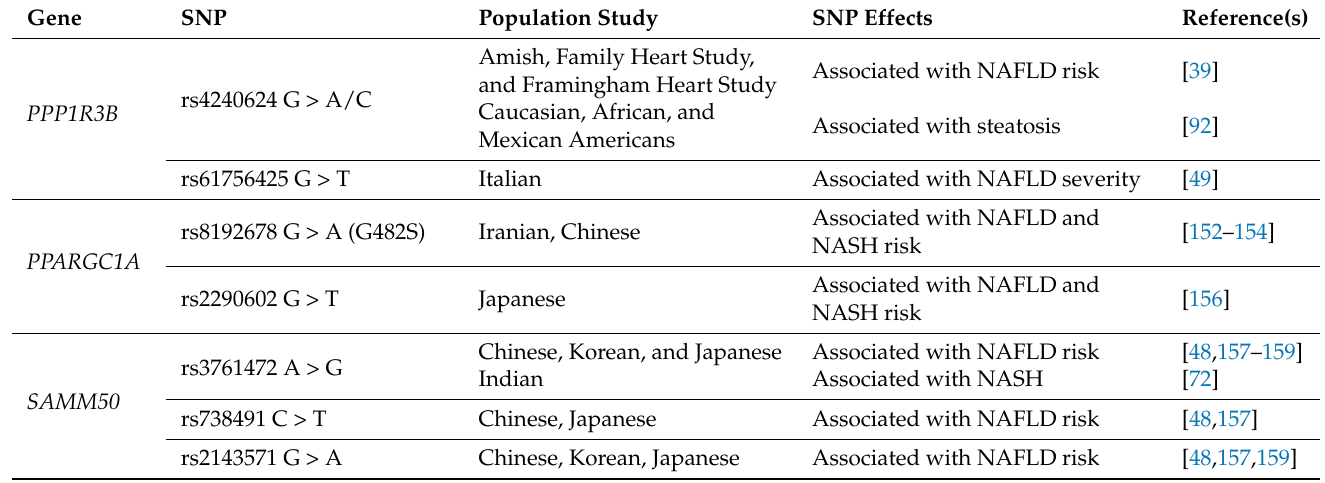
Table 2. Summary of the rarely reported single nucleotide polymorphism (SNP) associated with